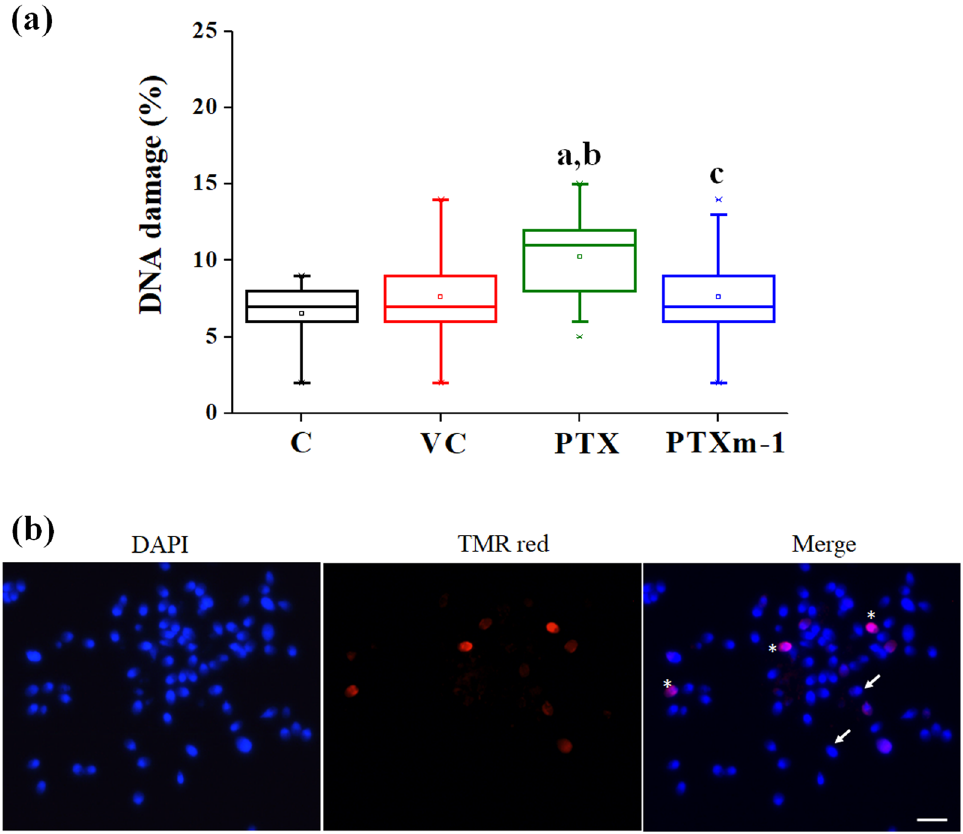
Figure 7. Effect of PTX and PTXm-1 in sperm wash media on DNA integrity of spermatozoa from normozoospermic samples. ( a ) The box and whisker plot represents median percentage of DNA integrity assessed by TUNEL assay at 24 h after swim up (N = 28). The error bar represents standard error to mean. ( b ) Representative image showing spermatozoa with intact DNA (arrow) and with DNA damage (TMR red positive, asterix). a: P < 0.001 compared to control; b: P < 0.01 compared to vehicle control; c: P < 0.01 compared to PTX. Magnification 400x; scale bar represents 10 µm. C: control; VC: vehicle control; PTX: pentoxifylline; PTXm-1: modified pentoxifylline.